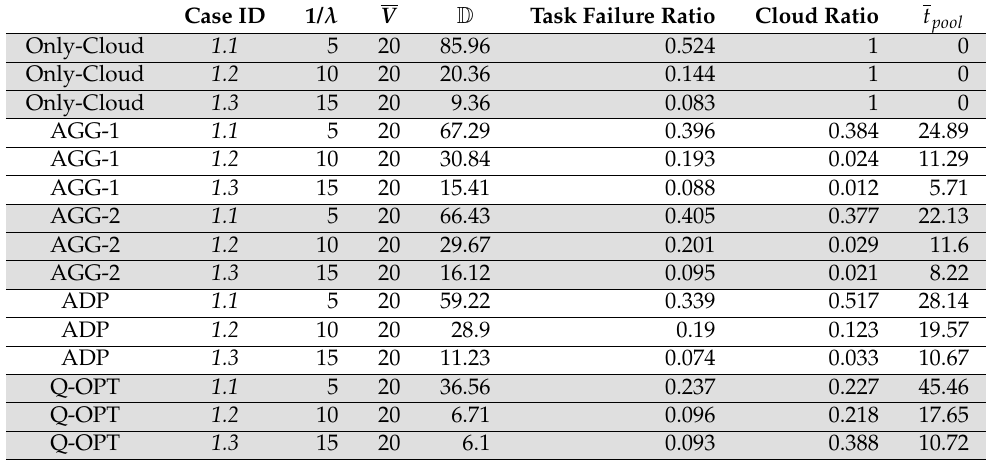
Table 6. Impact of task inter-arrival time on QoS and processing